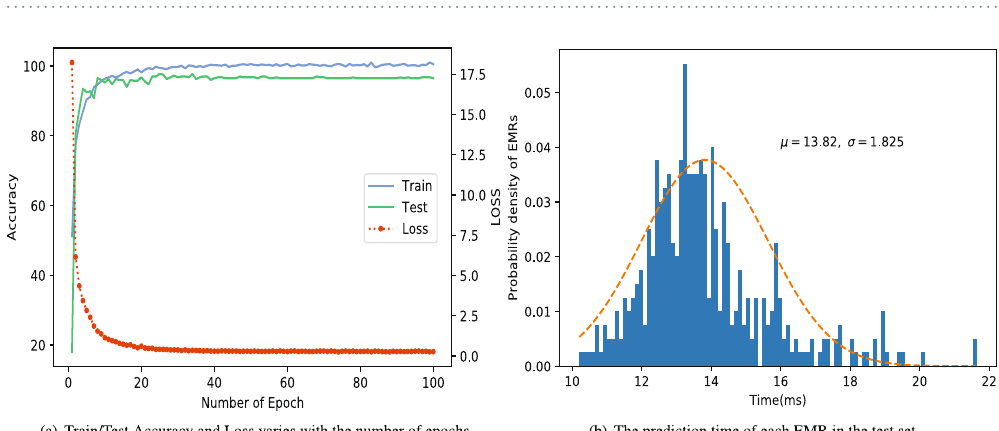
Figure 3. The processing of training. ( a ) Shows the accuracy of train/test set and the loss of the training set varies with the number of epochs. ( b ) Shows the prediction time of each EMR in the test